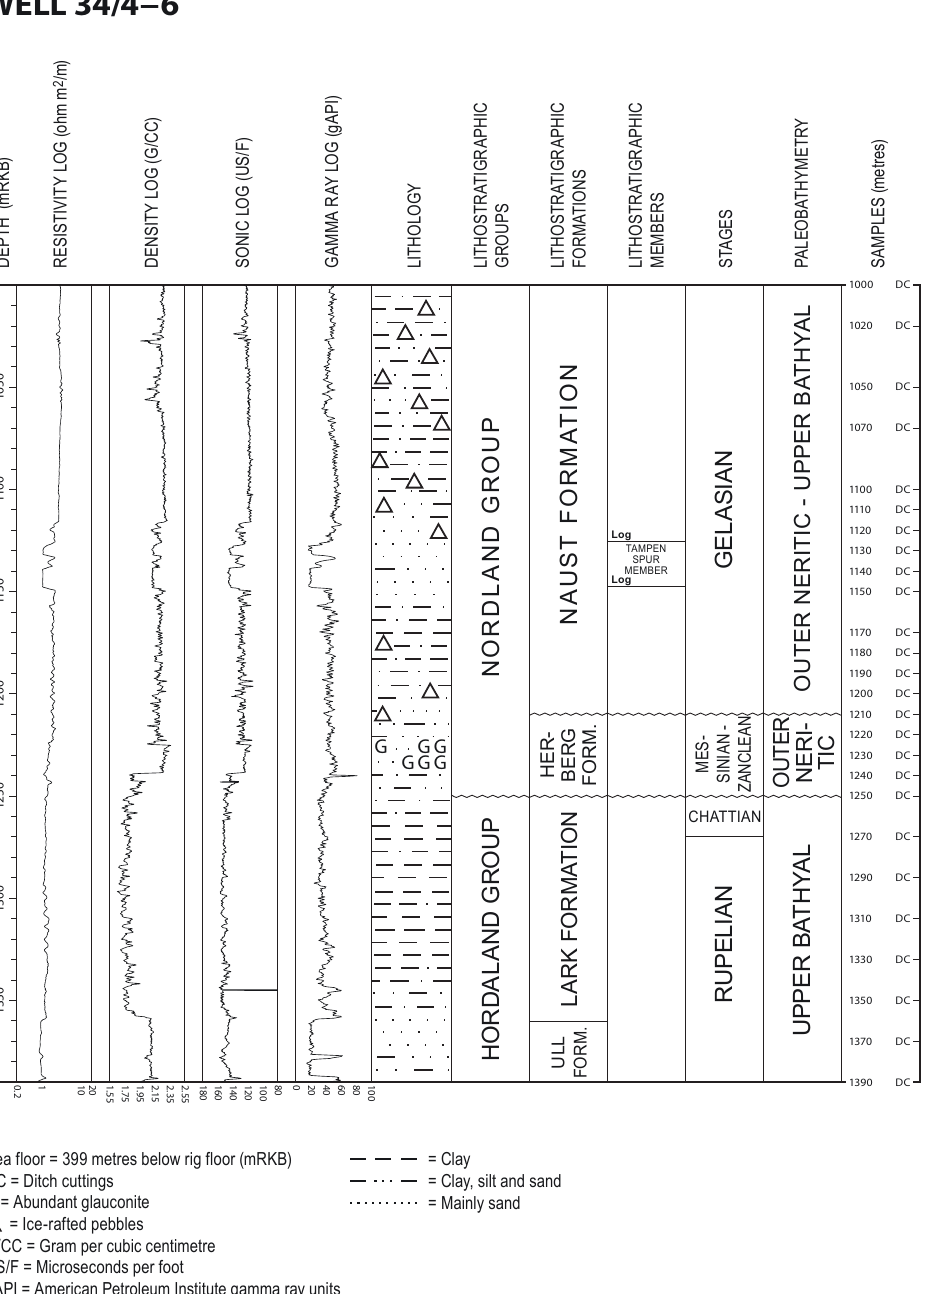
Figure 59. Well summary figure including resistivity log, density log, sonic log, gamma-ray log, lithology, litho- stratigraphic units, stages, paleobathymetry and analysed samples for the investigated sequence in well 34/4–6 (Rupelian to Gelasian) including the well type sections for the Herberg Formation (former the northernmost part of the Utsira Formation) and Tampen Spur Member (modified after Eidvin & Rundberg., 2001; Eidvin et al.,